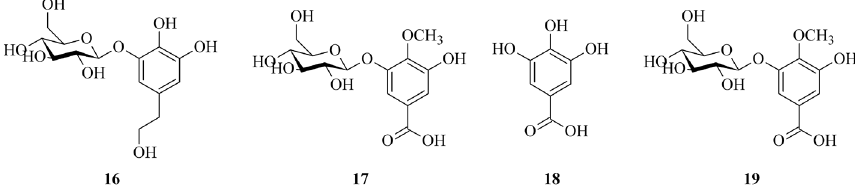
Figure 6 - New compounds ( 16 and 17 ) and bioactive compounds ( 18 and 19 ) isolated from S. tuberosa .